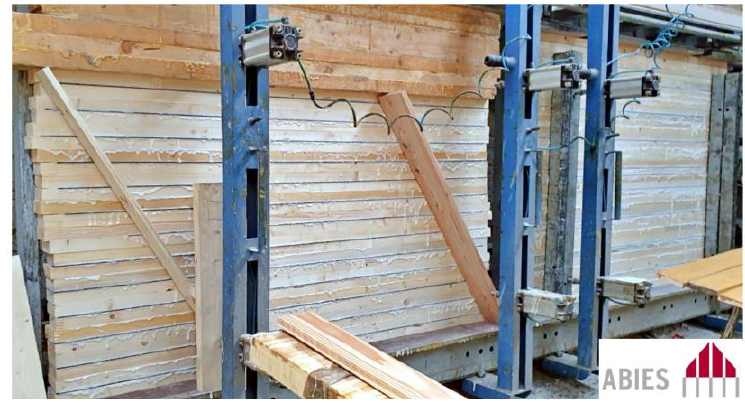
Figure 8. Gluing process at ABIES Poland Ltd.